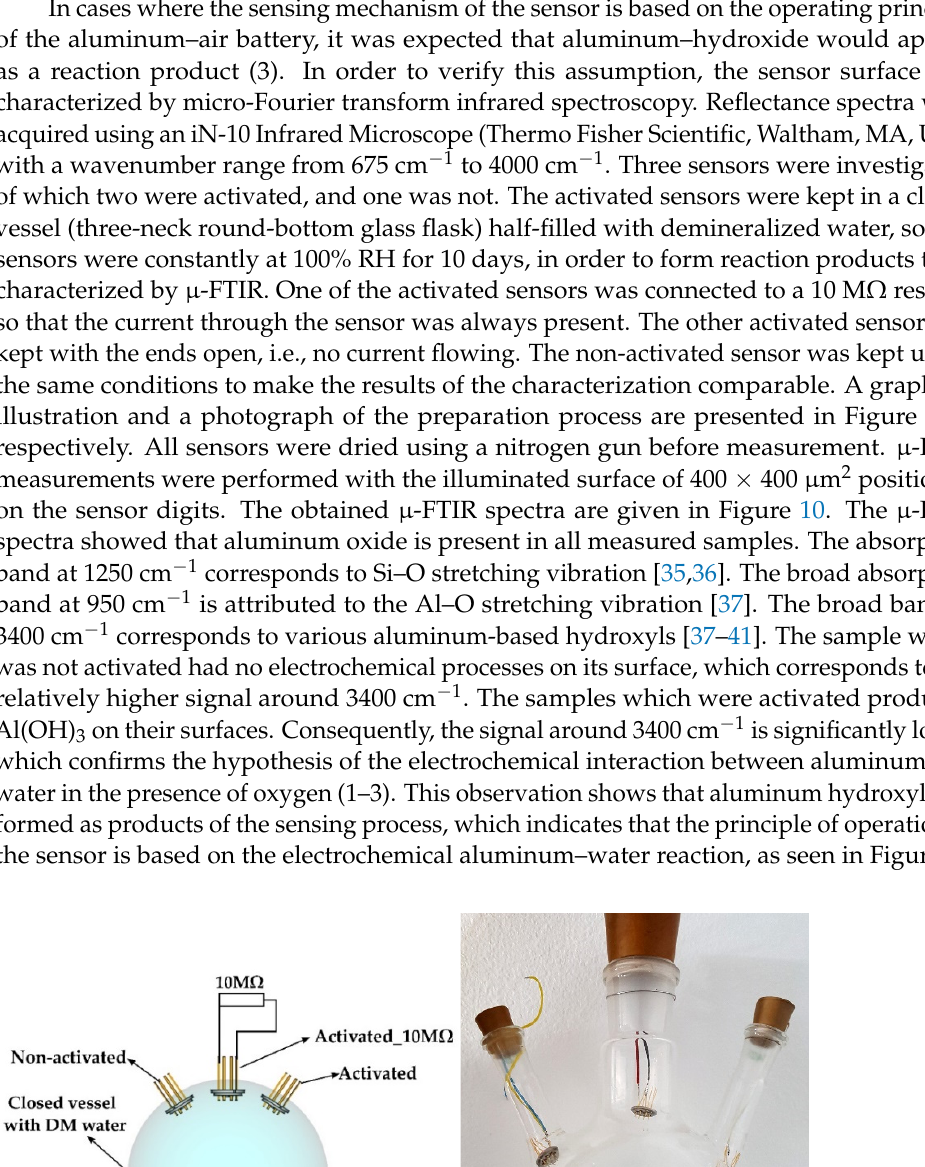
Figure 10. FTIR spectra of the tested samples: red—non-activated sensor; blue—activated sensor with open ends; black—activated sensor connected to a 10 M Ω resistor. 3.4. Electrochemical Impedance Spectroscopy The electrochemical characterization of the sensor was conducted via electrochemical impedance spectroscopy. Measurements were obtained using the Ivium Vertex 46804 (Ivium, Netherlands) in a frequency range from 300 Hz to 200 kHz, with the shorted ref- erence electrode and counter electrode, at the open circuit potential. In order to make the electrochemical reaction possible, a droplet of demineralized water was placed on the sen- sor’s surface. A Nyquist diagram is presented in Figure 11, together with the fitted data. The equivalent circuit which was used for analyzing the impedance data is given as an inset in Figure 11. Capacitive contributions were analyzed as constant phase elements (CPE), whose impedance is defined as: (cid:1852)((cid:1862)(cid:2033)) (cid:3004)(cid:3017)(cid:3006) =